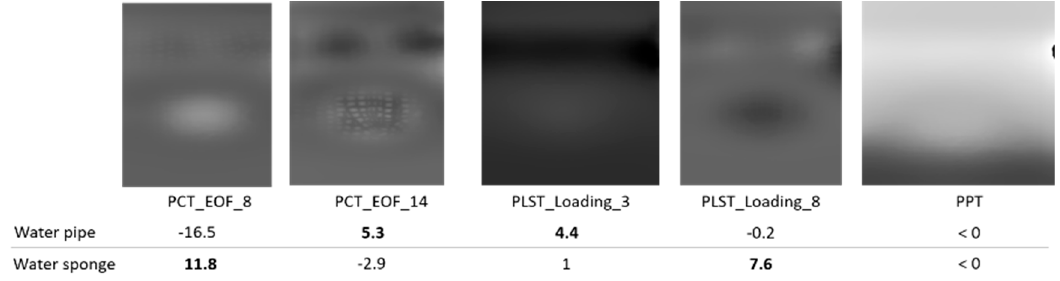
Figure 3. Best SNR results (black numbers) regarding the detection of the water recirculation through the pipe and the water propagation from the sponge, applying PCT, PLST and PPT and following experiment 2 of reference [3]. A description of the methodology here applied can be found in